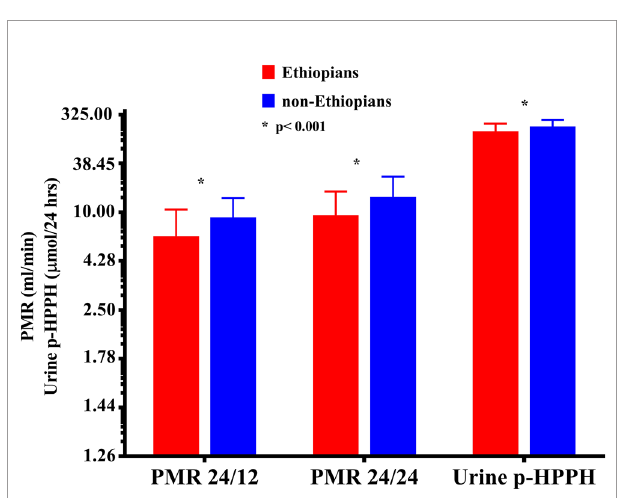
FIGURE 4 | The molar amount of p-HPPH in 24 urine collection, PMR24/12 and PMR24/24 in non-Ethiopian carriers of rs12777823 GG (yellow bars), GA (yellow hatched bars), and AA (black bars) genotypes. Log 10 transformed data was used for comparison with anti log 10 values presented on the y-axis. (Statistical comparison between carriers of different rs12777823 genotypes was performed by ANOVA on log 10 transformed